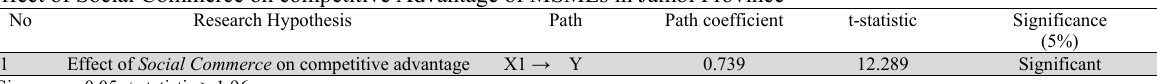
Effect of Social Commerce on competitive Advantage of MSMEs in Jambi Province